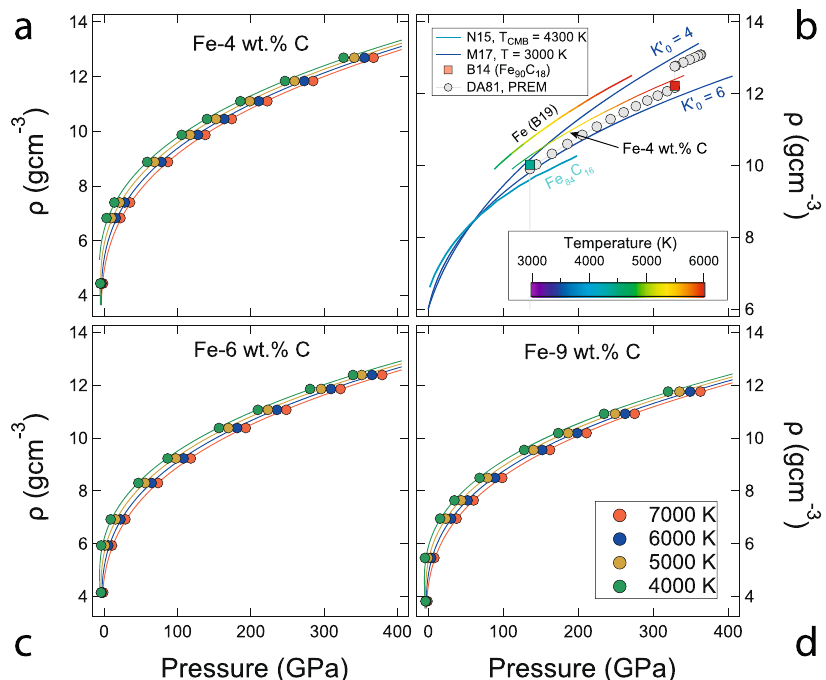
Fig. 1 Thermal equation of state of liquid Fe – C. Densities of iron alloy with ( a , b ) ~4 wt.%, ( c ) ~6 wt.%, and ( d ) ~9 wt.% of dissolved carbon as a function of pressure. Symbols are pressures estimated using fi rst-principles molecular dynamics (FPMD) simulations at constant density, at 7000K (red), 6000 K (blue), 5000K (brown), and 4000 K (green). The pressure-density data from FPMD can be adequately described by a thermal equation of state (Table 1). Panel ( b ) shows the density of pure liquid iron, B19 59 and liquid Fe-4 wt.% C (this study) calculated along the geotherm with inner-core temperature ( T ICB = 6000 K) (Supplementary Fig. S2). Filled squares represent the density of liquid iron alloy with a stoichiometry of F C (~4 wt.% C) from FPMD 90 18 simulations at core conditions 6 . Experimental results of the density of liquid iron alloy with a stoichiometry of F 84 C 16 (~4 wt.% C) liquid up to 200 GPa ¼ 4300K) is also shown (cyan line) for comparison 53 . Blues lines are the BM3 isothermal equation of state representation of along geotherm (with T CMB ¼ 6 : 0gcm (cid:2) 3 , K ¼ 89 : 0GPa, K 0 ¼ 4 : 0, and ρ ¼ 6 : 0gcm (cid:2) 3 , K ¼ 65 : 0GPa, K 0 ¼ 6 : 0 52 . Error in pressures liquid iron with ~3 wt.% carbon with ρ T T T T 0 0 represents ±1 σ uncertainties which are smaller than the size of the symbols.